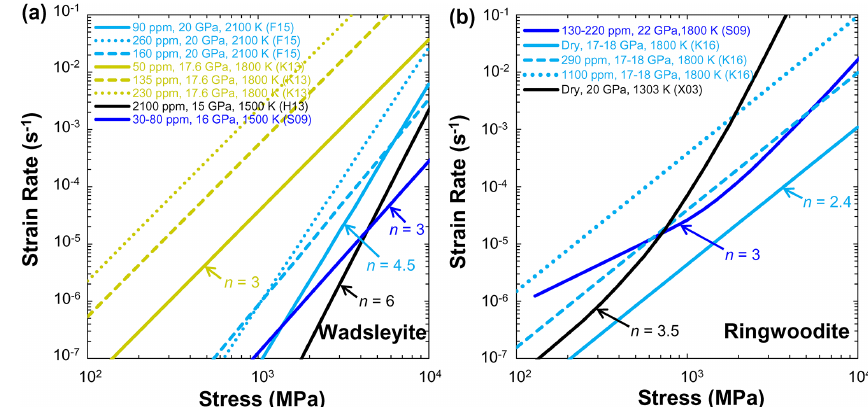
Figure 14. Plots of strain rate versus differential stress for (a) wadsleyite and (b) ringwoodite deformed under dry and wet conditions. Data sources: K13 (Kawazoe et al., 2013); H13 (Hustoft et al., 2013); F15 (Farla et al., 2015); S09 (Shimojuku et al., 2009); X03 (Xu et al., 2003); K16 (Kawazoe et al.,